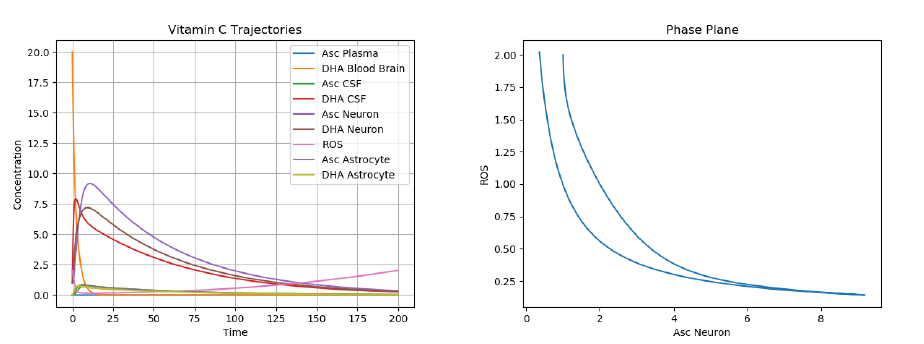
Figure 4. Dynamics of AA, DHA, and ROS during Stroke with High Dose DHA